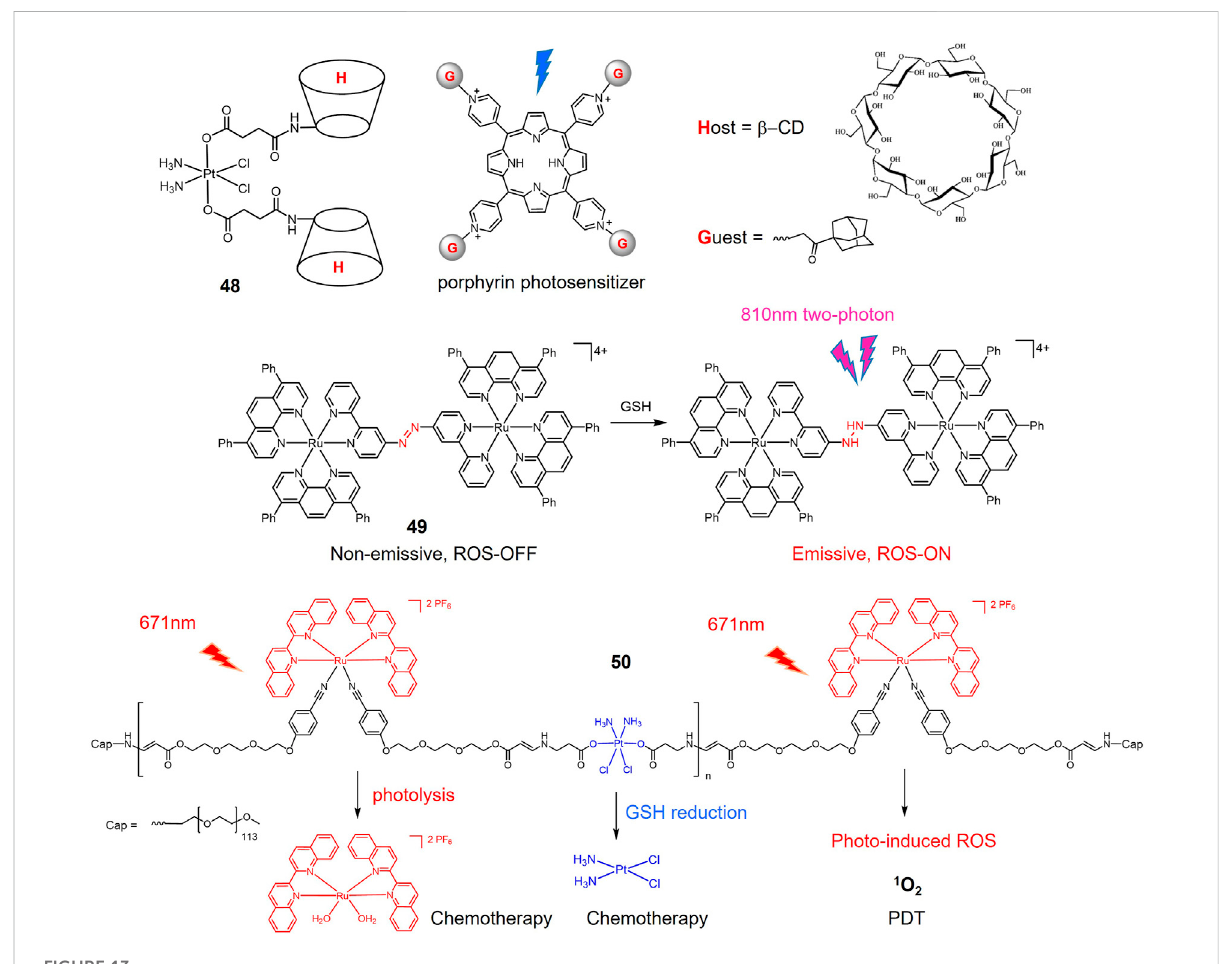
FIGURE 13 Redox/light dual-responsive Pt(IV) and Ru(II)